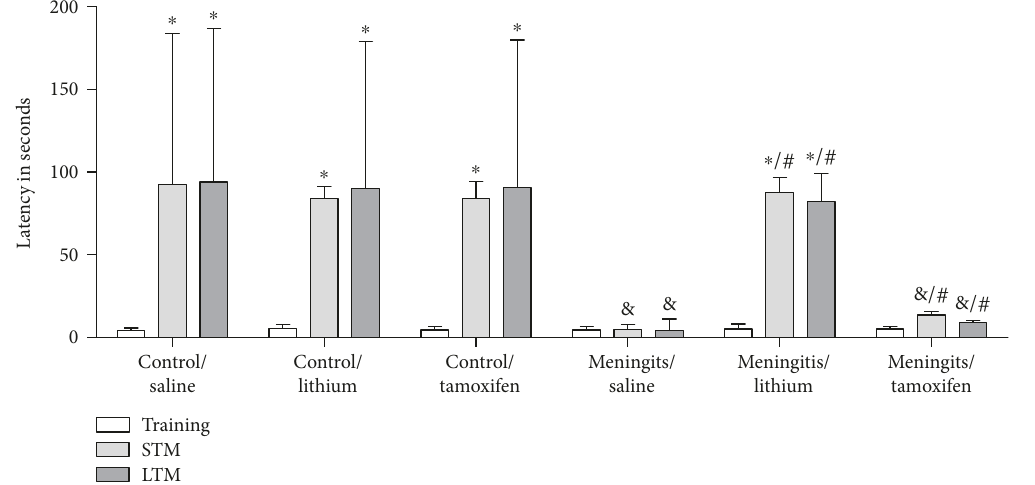
Figure 3: E ff ects of lithium and tamoxifen on step-down inhibitory avoidance task in adult Wistar rats 10 days after pneumococcal meningitis induction. Data are reported as median and interquartile ranges, and comparisons among groups were performed using Mann – Whitney U tests ( n = 12 ). The within-individual groups were analyzed by Wilcoxon ’ s tests. ∗ P < 0 05 indicates di ff erences between training and test sessions as determined by Wilcoxon, & P < 0 05 indicates the statistical signi fi cance of the control/saline group as described by Mann – Whitney, and # P < 0 05 indicates statistical signi fi cance of the meningitis/saline group as determined by Mann –